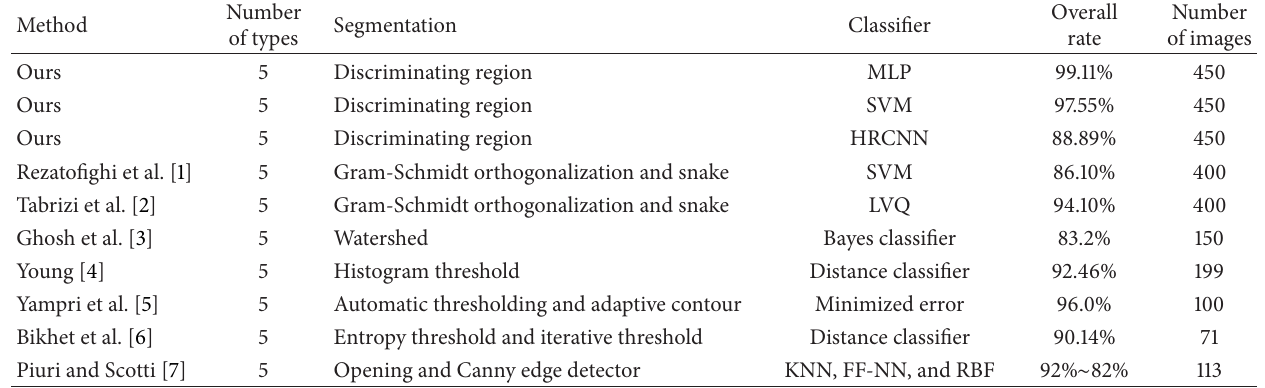
Table 4: The comparisons of the classification rates among different classification